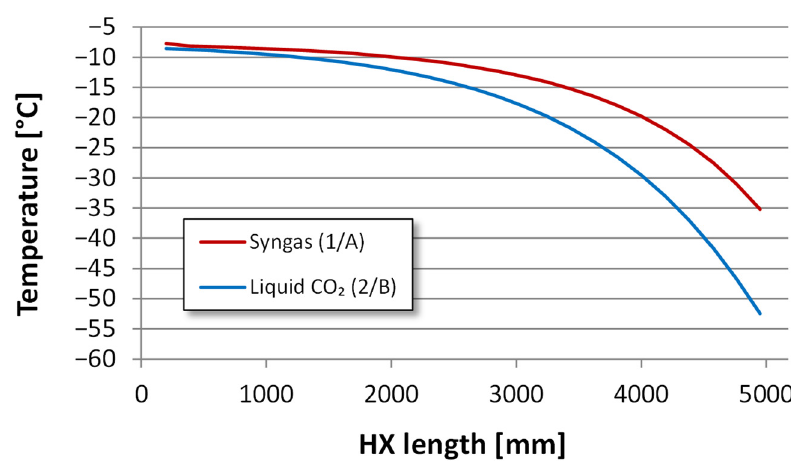
Figure 9. Temperature profiles for plate-fin heat exchanger HX1.